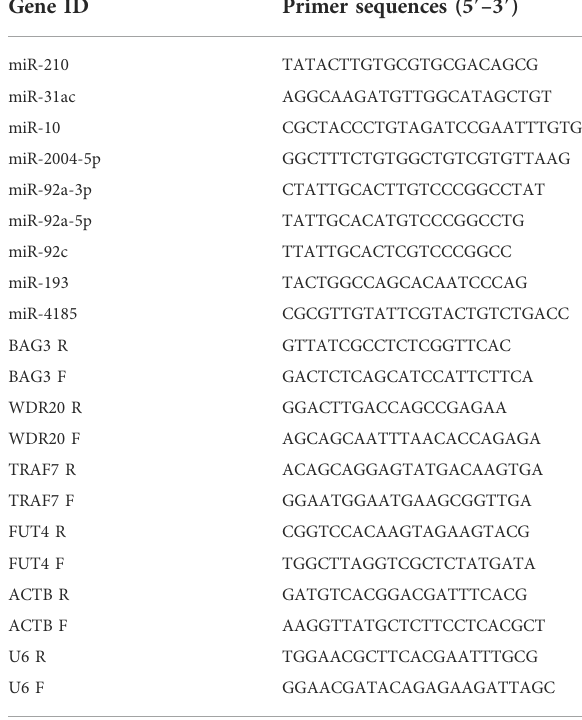
TABLE 1 RT-qPCR primers used for validation of this